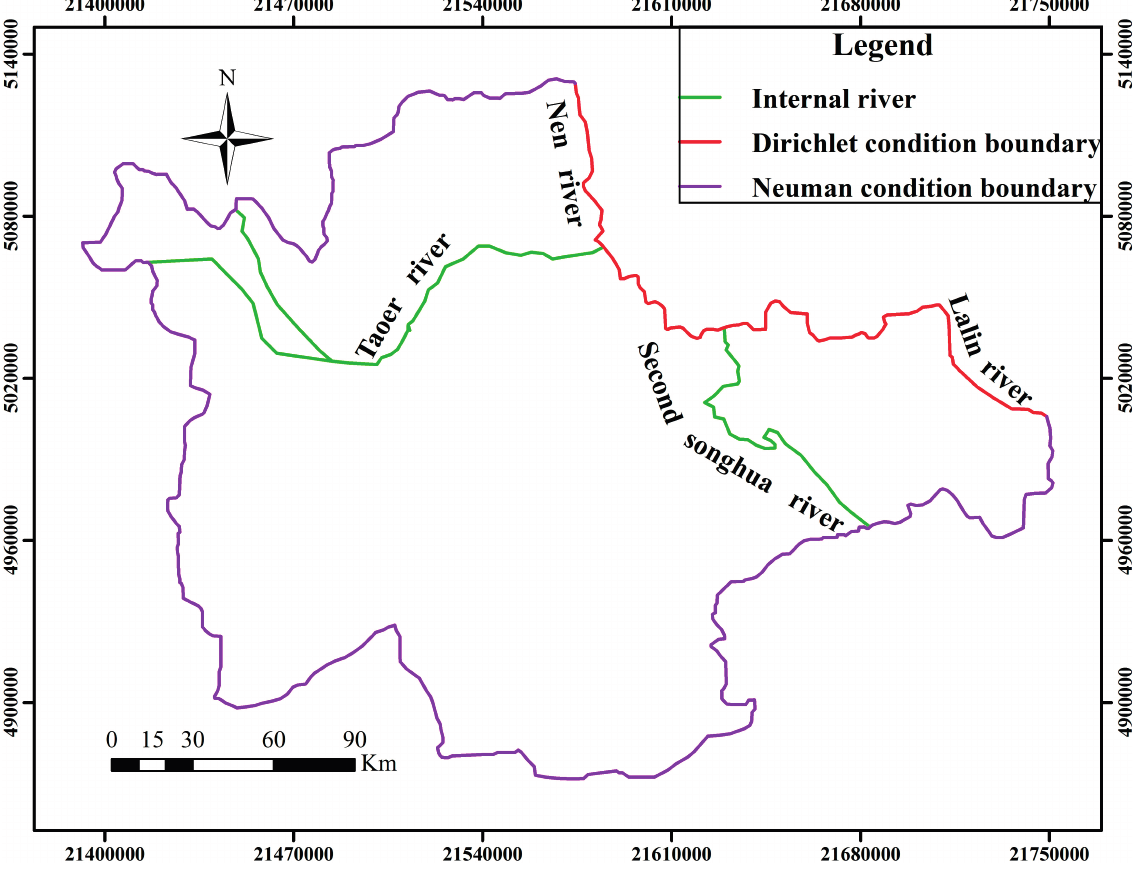
Figure 1. Types of lateral boundary in study